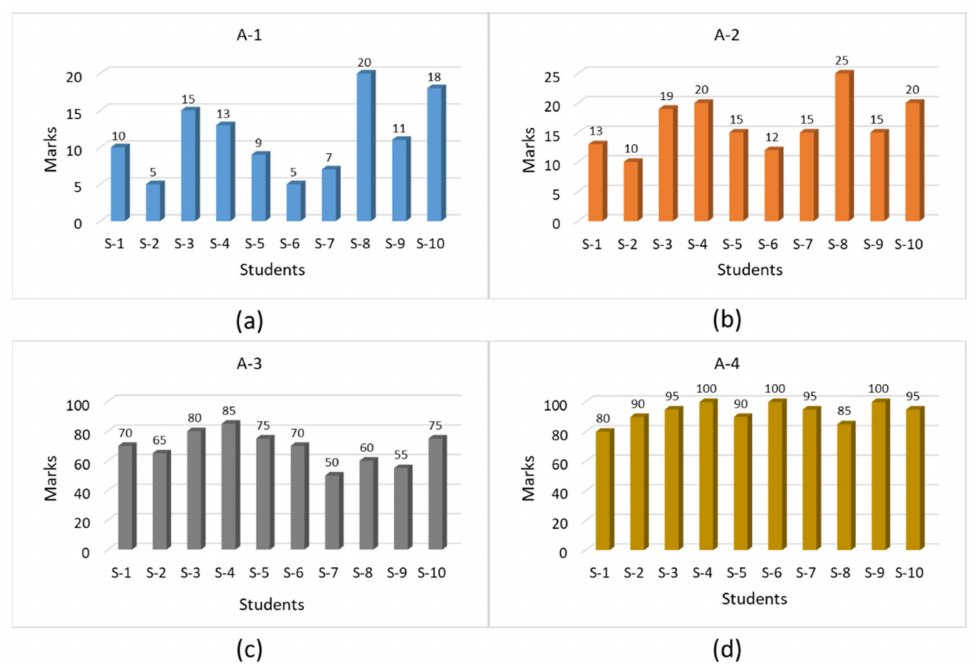
Figure 12. ( a ) test score before training, ( b ) score after traditional methods-based training, ( c ) score after VR-based training, ( d ) score after self-practice and children’